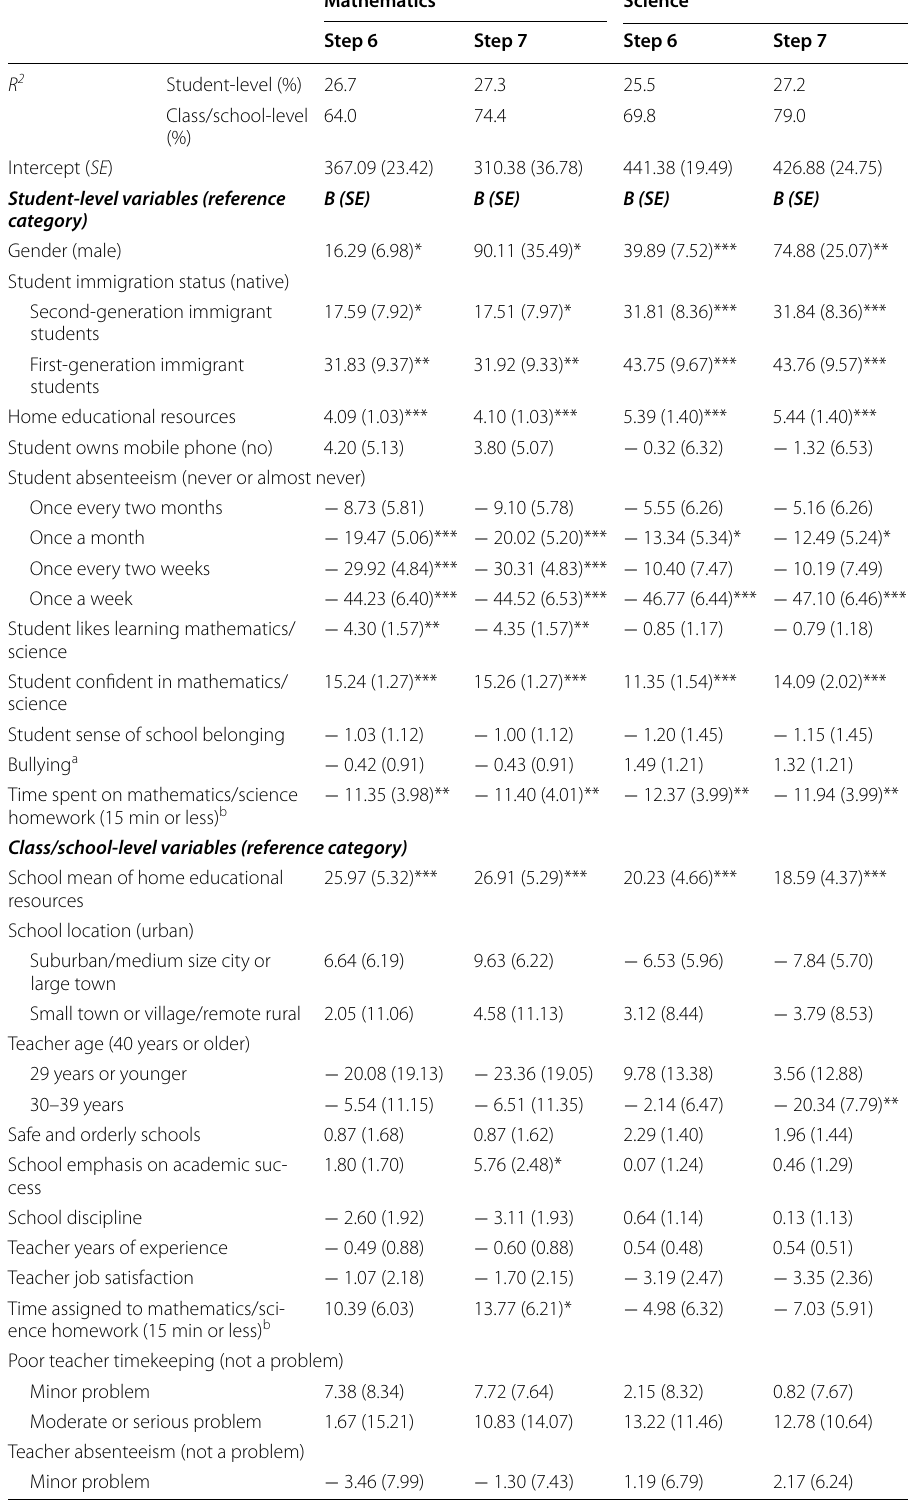
Table 11 Steps 6 and 7 from the hierarchical two‑level linear regression models for mathematics and science achievement, grade 8, TIMSS